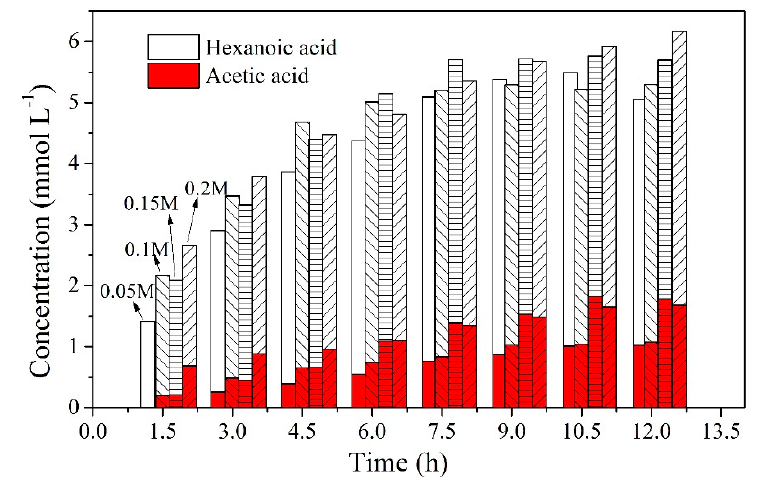
Figure 10. The changes in the acid concentration in the stripping solution with different HCl concentrations in the stripping solution (PIMs: PIM4; Feed solution: 0.01 mol L − 1 acetic acid + 0.01 mol L − 1 hexanoic acid, pH = 6; Stripping solution: 0.05, 0.1, 0.15 and 0.2 mol L − 1 HCl).